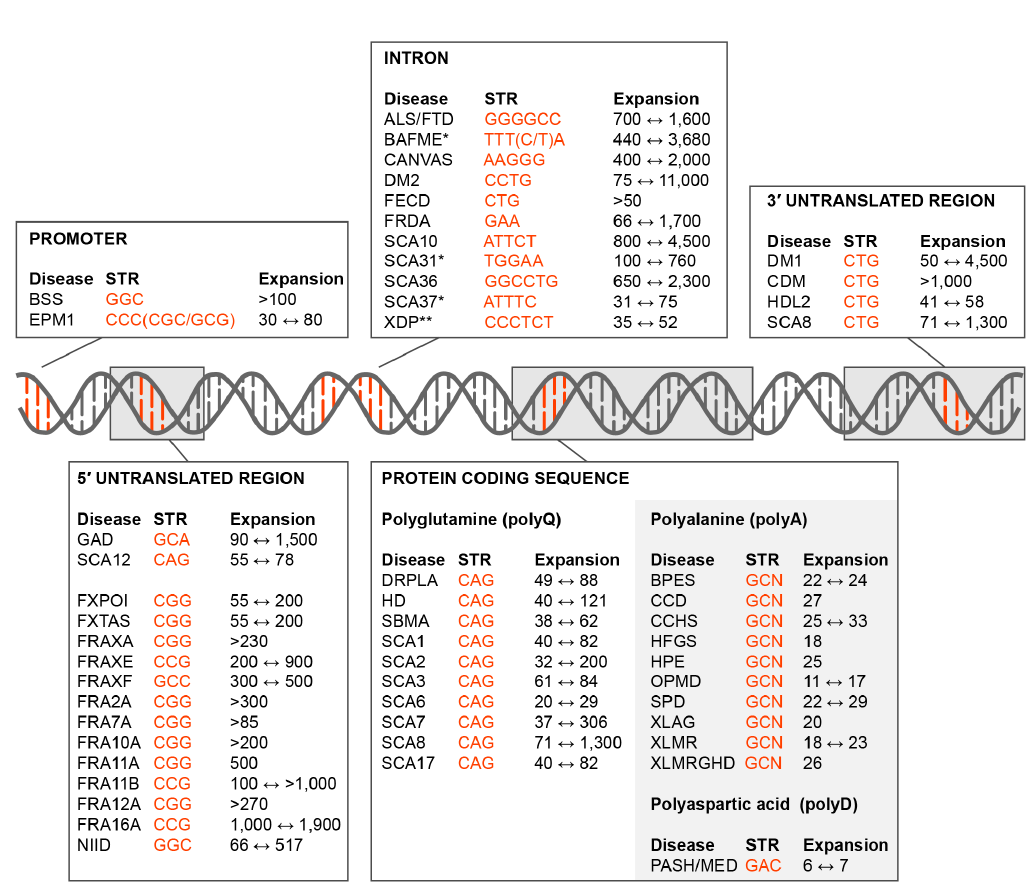
Figure 1. Short tandem repeat (STR) expansion disorders. Diseases caused by STR (orange font) expansions in the promoter, 5’ untranslated region (5’UTR), introns, coding region and 3’ untranslated region (3’UTR) are shown together with the disease acronym and pathogenic expansion range (black font). Some of these mutations are not classical expansions but are insertions due to replication / recombination / duplication (Intron, SCA31, SCA37, BAFME, *; Protein Coding Sequence, Polyalanine and Polyaspartic acid, light grey box) or retrotransposon (Intron, XDP, **) events. Disease-associated STR locations include the: • Promoter. Baratela-Scott Syndrome (BSS) linked to XYLT1 gene [6], Progressive Myoclonus Epilepsy (EPM1)– CSTB [7]; • 5’UTR. Glutaminase Deficiency